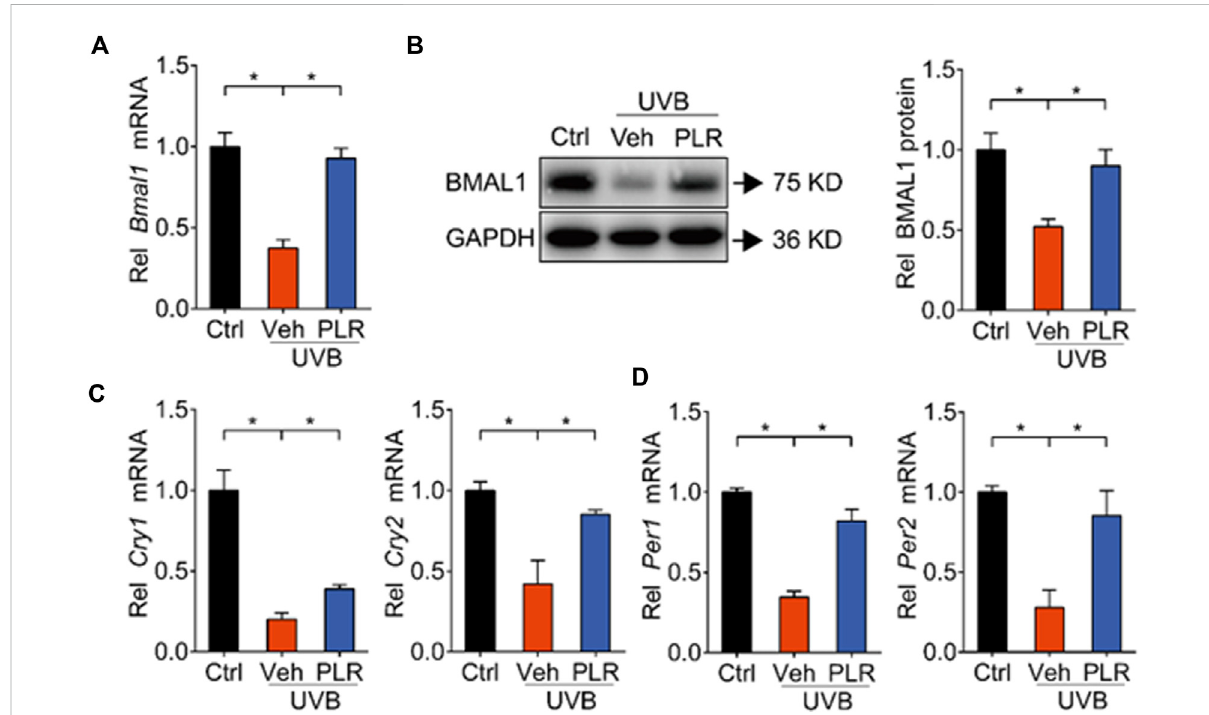
FIGURE 5 PLR modulates the expression of clock genes in senescent cells. 1 μ g/ml PLR was used to treat the L929 cells. RT-qPCR and Western blotting werecarriedouttodetecttheexpressionlevelsofcoreclockgenes. (A) mRNAlevelof Bmal1 . (B) proteinlevelofBMAL1. (C) mRNAlevelsof Cry1 and Cry2 . (D) mRNA levels of Per1 and Per2 . Data are presented as mean ± SD ( n = 3). * p < 0.05. Ctrl, control; Veh,